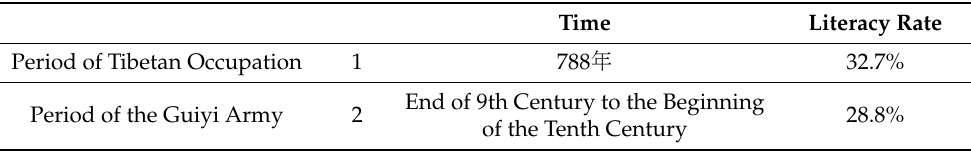
Table 9. The literacy rate of Dunhuang nuns in the period of Tibetan occupation and the period of the Guiyi